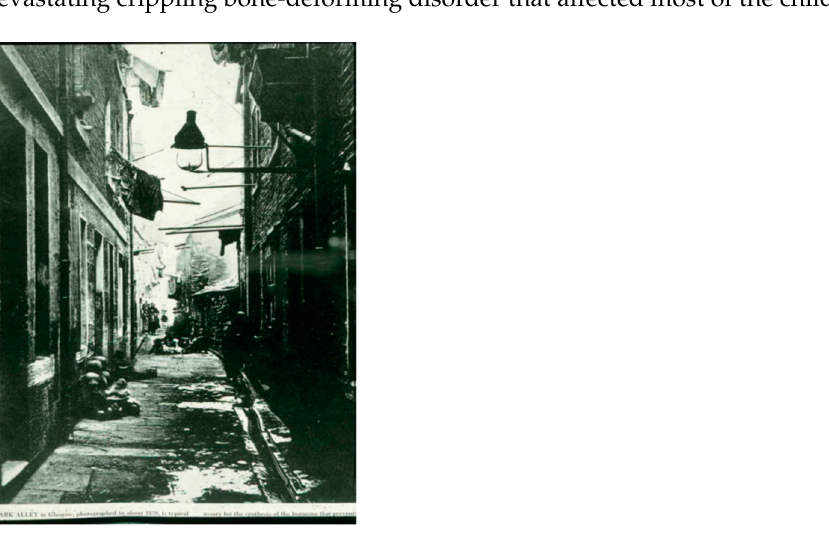
Figure 1. Photograph from Glasgow, Great Britain, in about 1870 showing that the buildings are built near each other. Ref. [5] Holick, copyright 1994. Reproduced with permission.